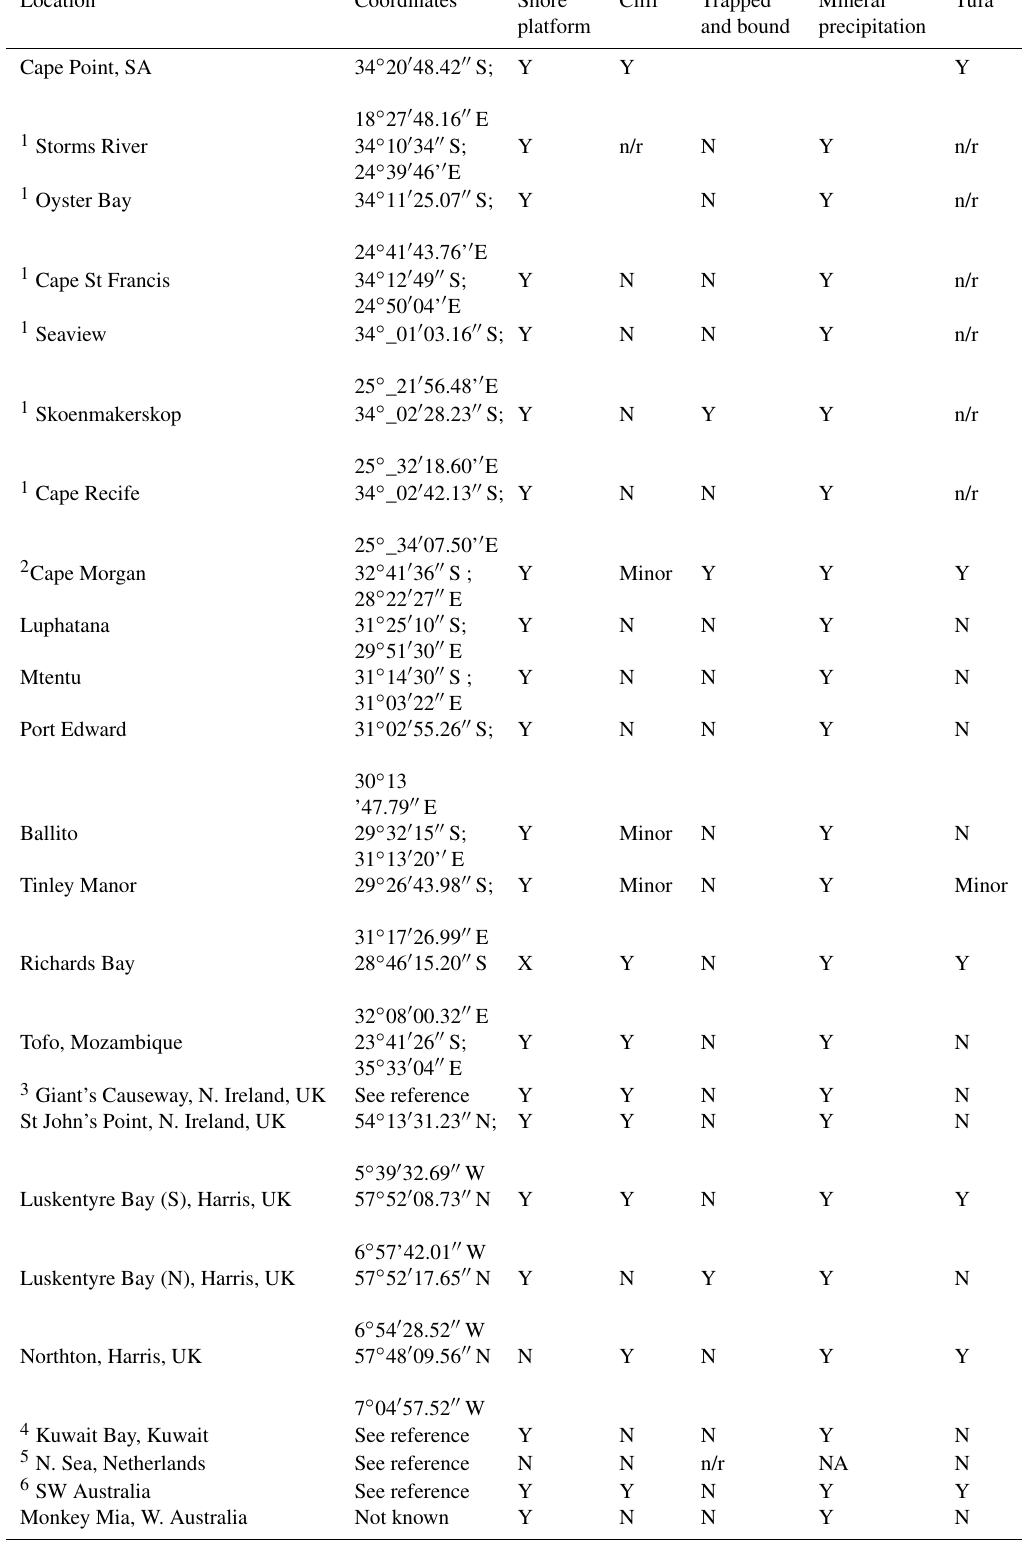
Table 1. Location, context and stromatolite type of SPS localities (Y: yes; N: no; n/r: no record). Location